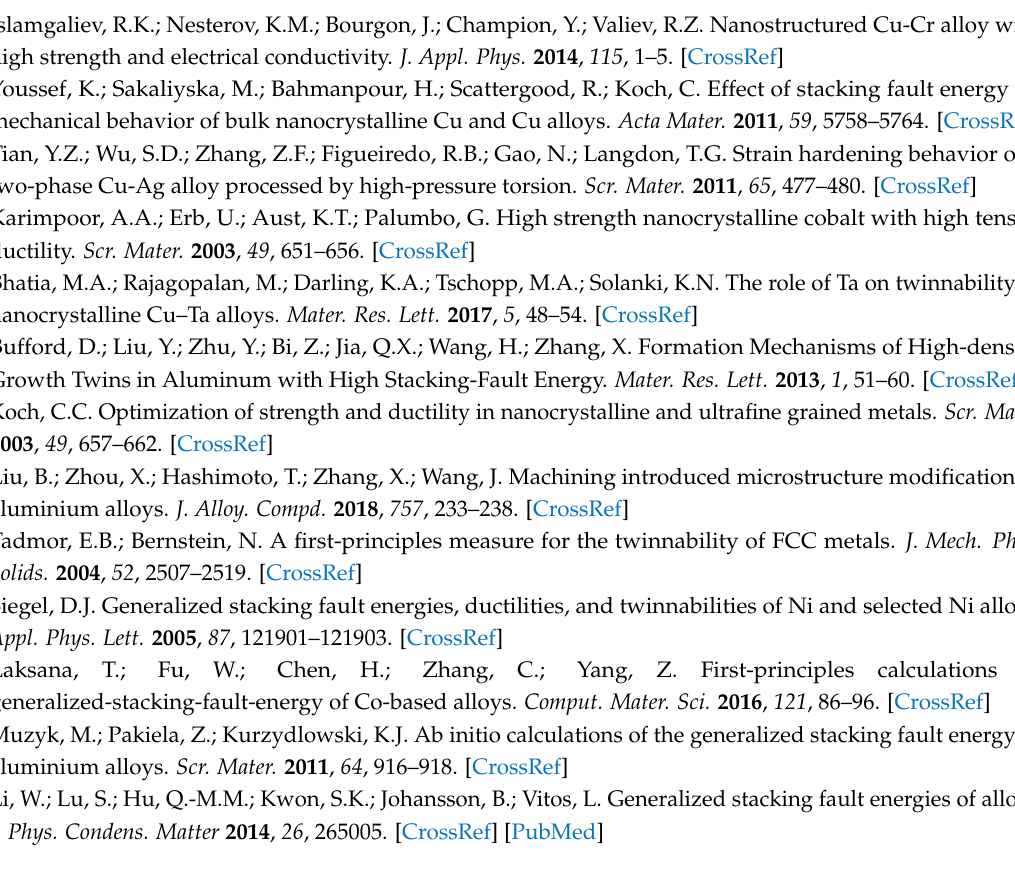
Figure S1: The geometry of the (111) plane in fcc structure is shown. ABC layers of atoms are marked by red, green and blue circles, respectively. Black arrows indicate the direction and length of the partial dislocation slip. The red arrow shows the full dislocation